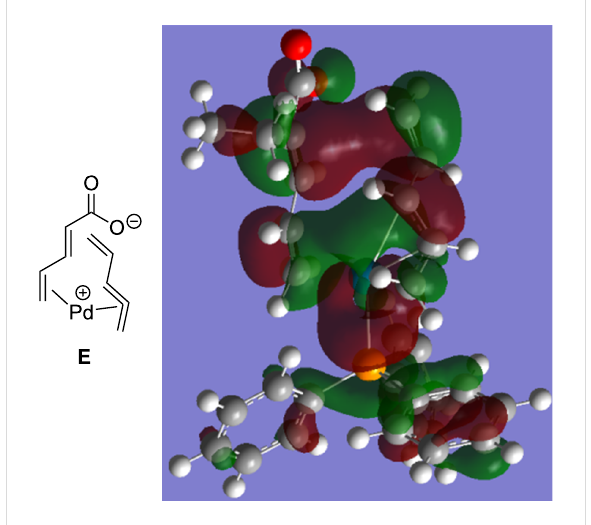
Figure 1: Calculated HOMO of transition state between E and F